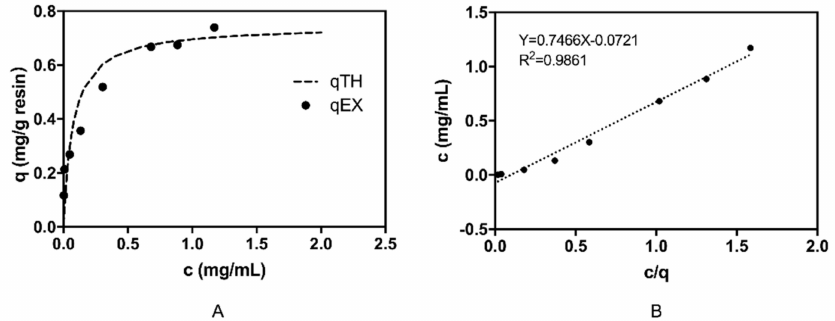
Figure 5. The static adsorption performance of the VHH-based adsorbent in plasma. ( A ) The isothermal adsorption curve of the sorbent at room temperature; qEX represents the test data while qTH represents the theoretical data. ( B ) The rearranged linearization curve. The slope of the curve was the maximal adsorptive capacity of the gel, and the intercept of curve was the opposite number of Kd . Y represents the equilibrium concentration of β 2-m; X represents c / q (see Equation 2 in Method